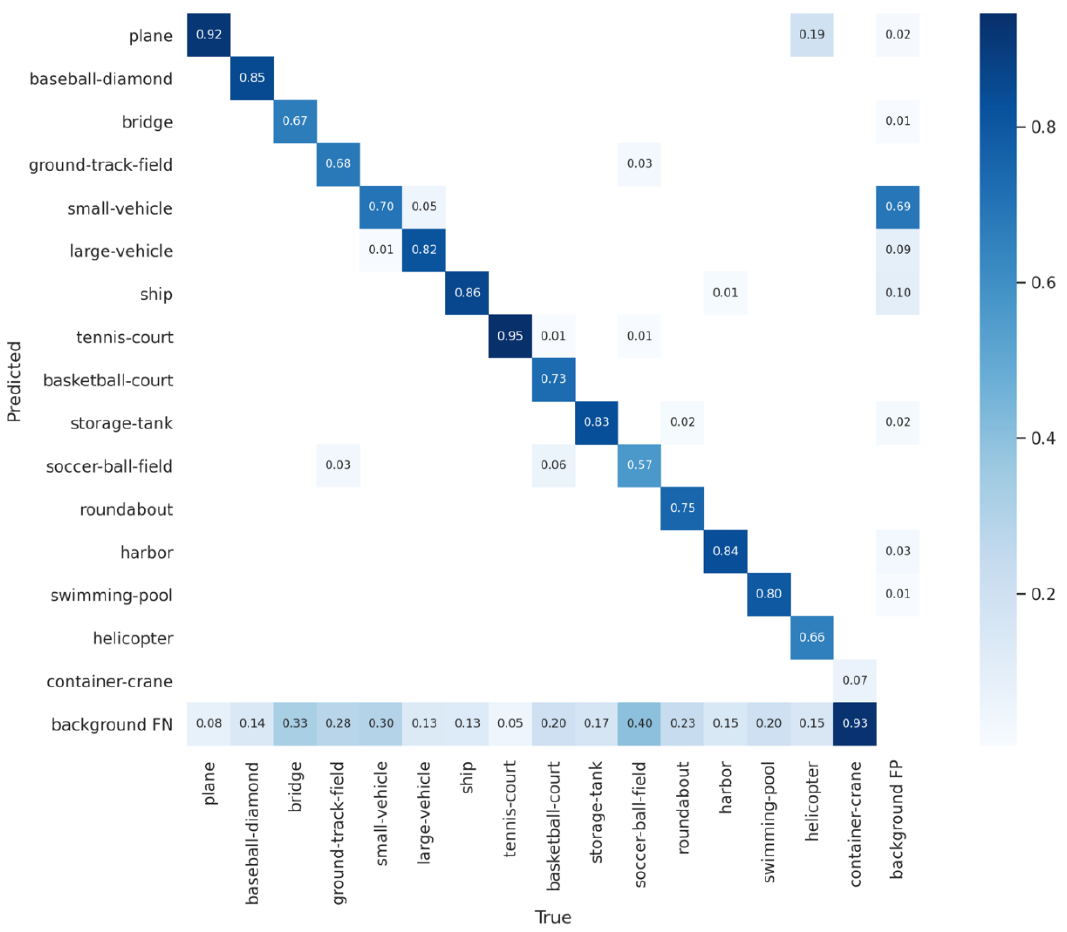
Figure 5. The confusion matrix from the SPH-YOLOv5 results on the DOTA test set, with the IoU threshold of 0.5 and the confidence threshold of 0.25, respectively.